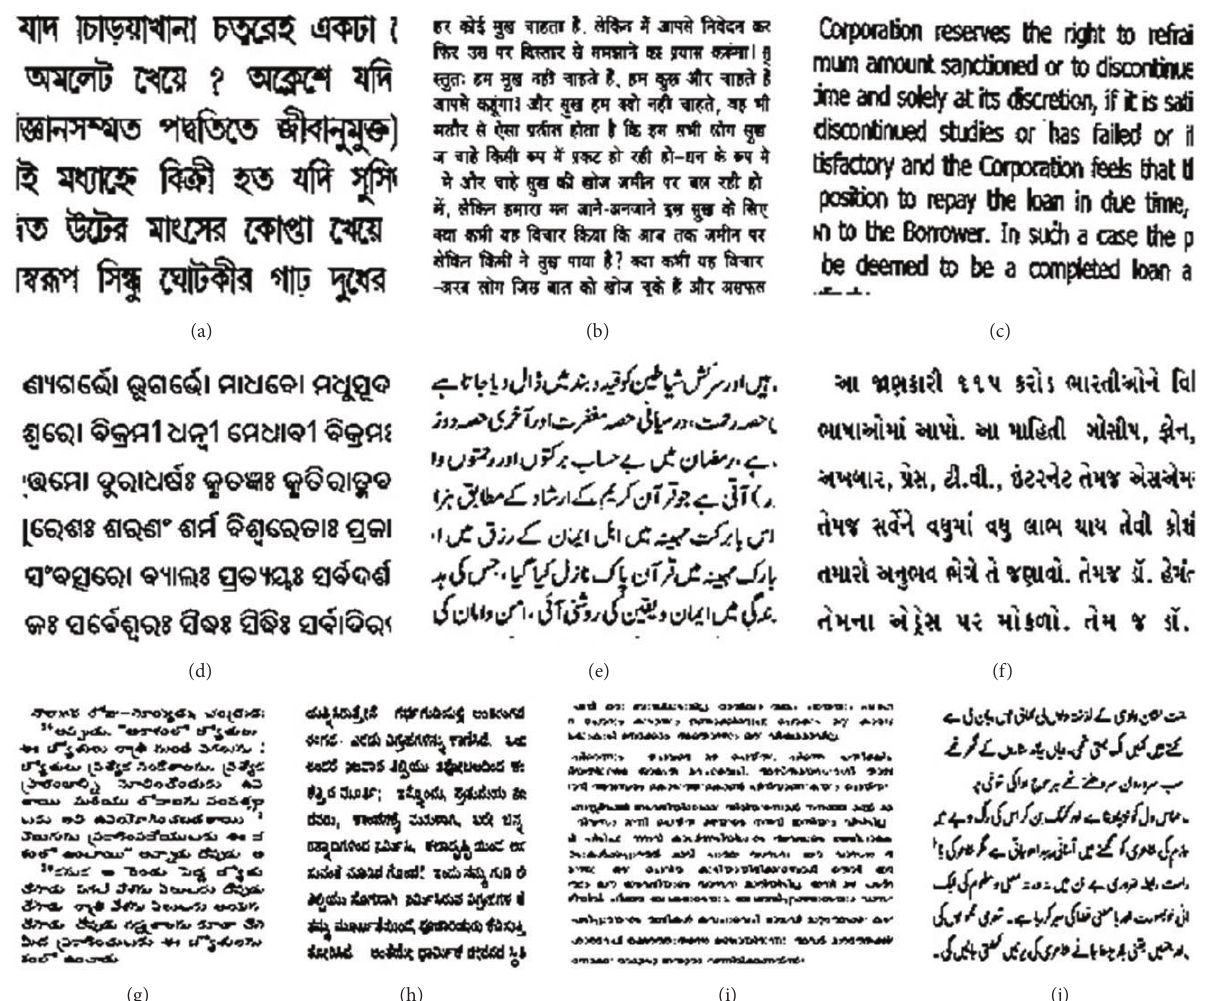
Figure 3: Sample from our database of (a) Bangla, (b) Devanagari, (c) Roman, (d) Oriya, (e) Urdu, (f) Gujarati, (g) Telugu, (h) Kannada, (i) Malayalam, and (j) Kashmiri script